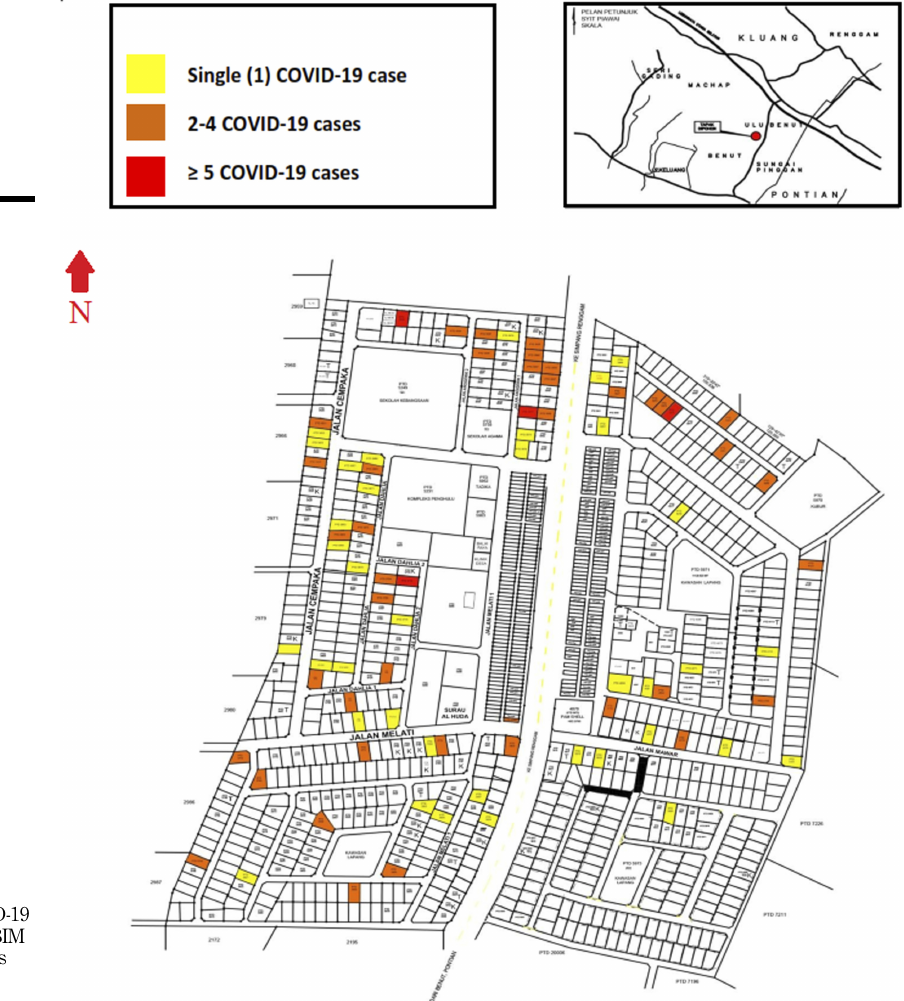
Figure 3. Mapping of COVID-19 cases in EMCO BBIM by number of